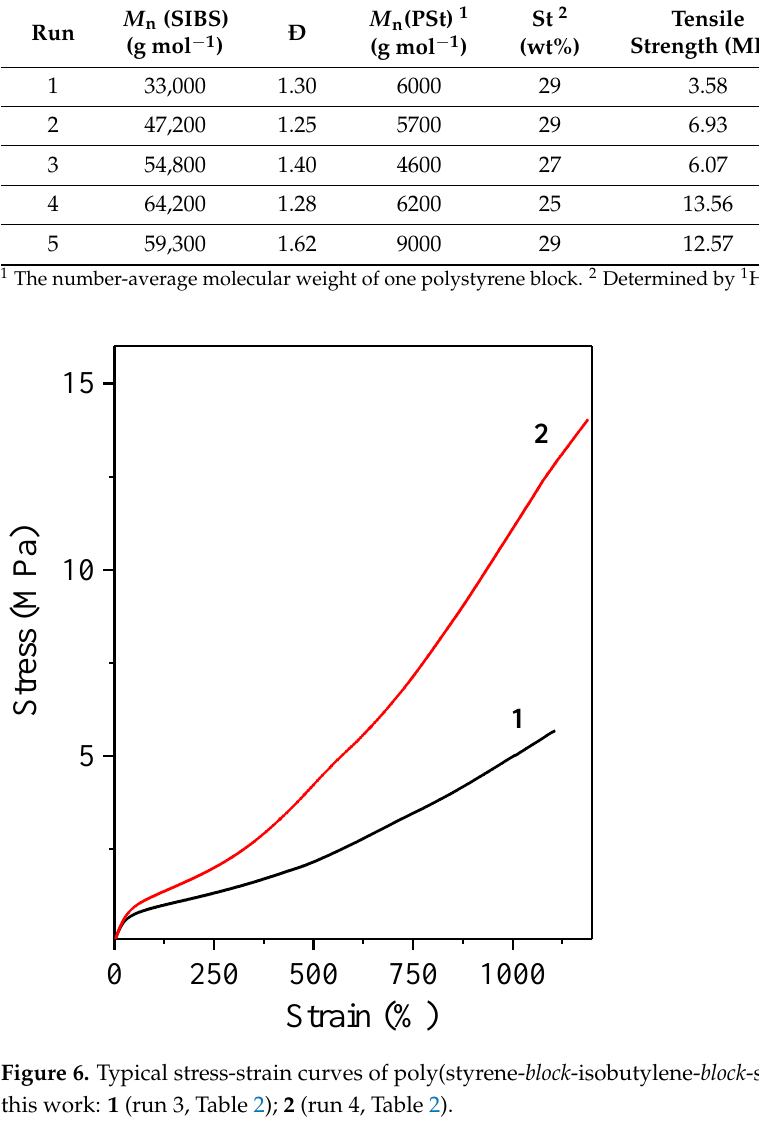
Table 2. Tensile properties of SIBS triblock copolymers of different composition at 24 ◦ C. Run